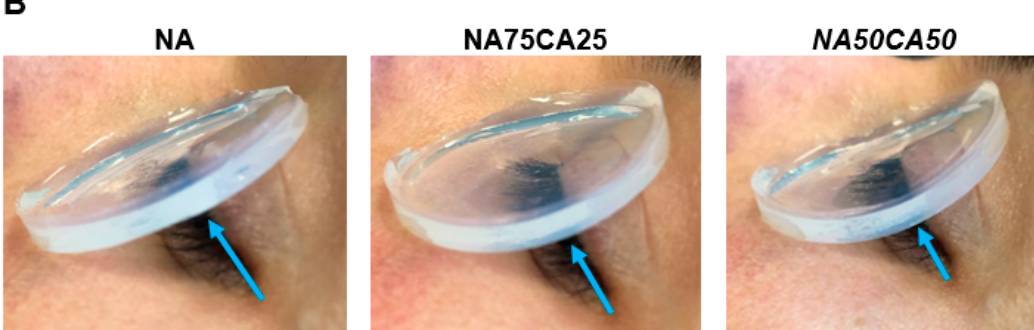
Figure 4. ( A ) Plot of Young’s moduli versus wt.% of CA in total weight of polysaccharide. A near-linear relationship can be observed. ( B ) Young’s moduli of hydrogel blends loaded with cefazolin and doxycycline, respectively, compared with antimicrobial-free blends (blank hydrogels). Suggesting that a 0.5% load of antimicrobial agents does not affect the modulus of an NA–CA hydrogel. ( C ) Flexibility of the hydrogel pads assessed on a human eye. Blue arrow shows the increased curvature of the hydrogel as the concentration of CA increases.